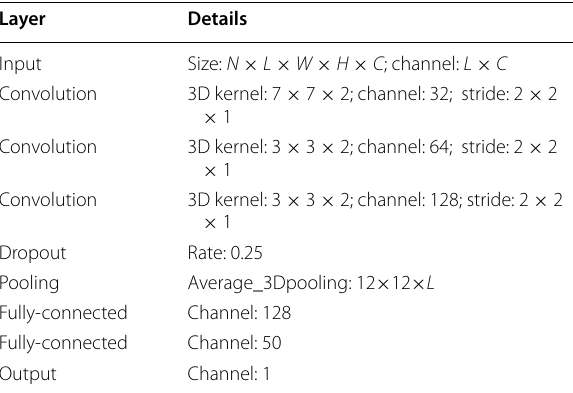
Table 1 Details of proposed model architecture by